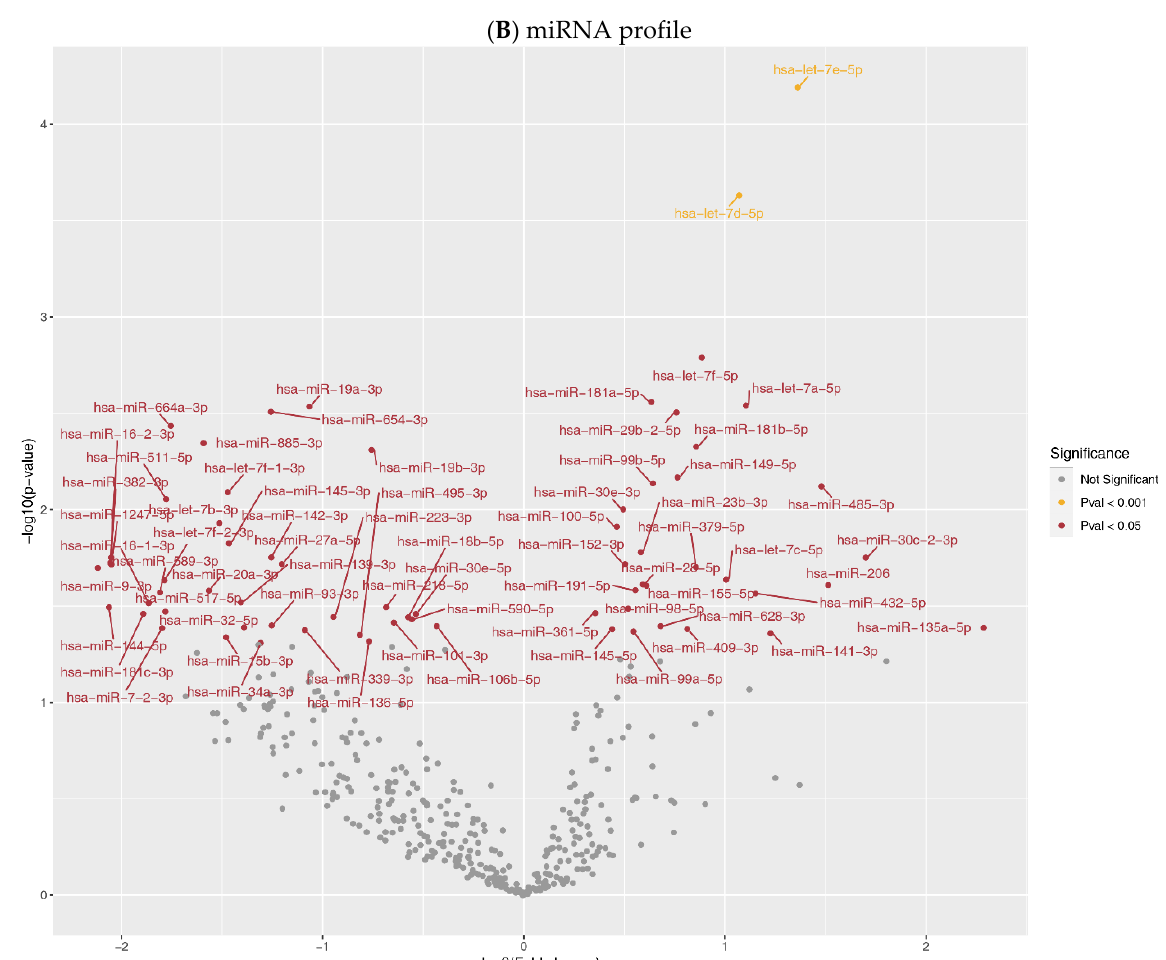
Figure 1. Expression profiles in aortic tissue. Volcano plot of comparative mRNA resp. miRNAs expression profiles in samples before and after LVAD support; x-axis indicates difference in expression level on a log2 scale; y-axis represents corresponding P -values on a negative log scale. ( A ) mRNA profile: yellow points indicate mRNAs with Pcorr < 0.001; red points indicate mRNAs with Pcorr < 0.05, & Pcorr > 0.001, & |logfc| > 3.5.; ( B ) miRNA profile: yellow points indicate miRNAs with Pcorr < 0.001; red points indicate miRNAs with Pcorr < 0.05, & Pcorr > 0.001.